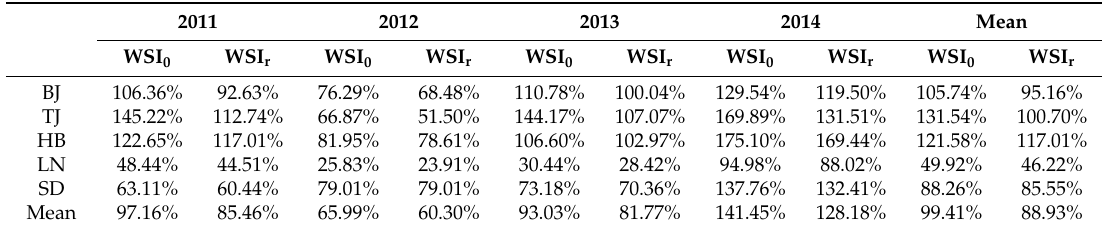
Table 4. Changes of water stress index in Bohai Bay city agglomeration, 2011–2014.